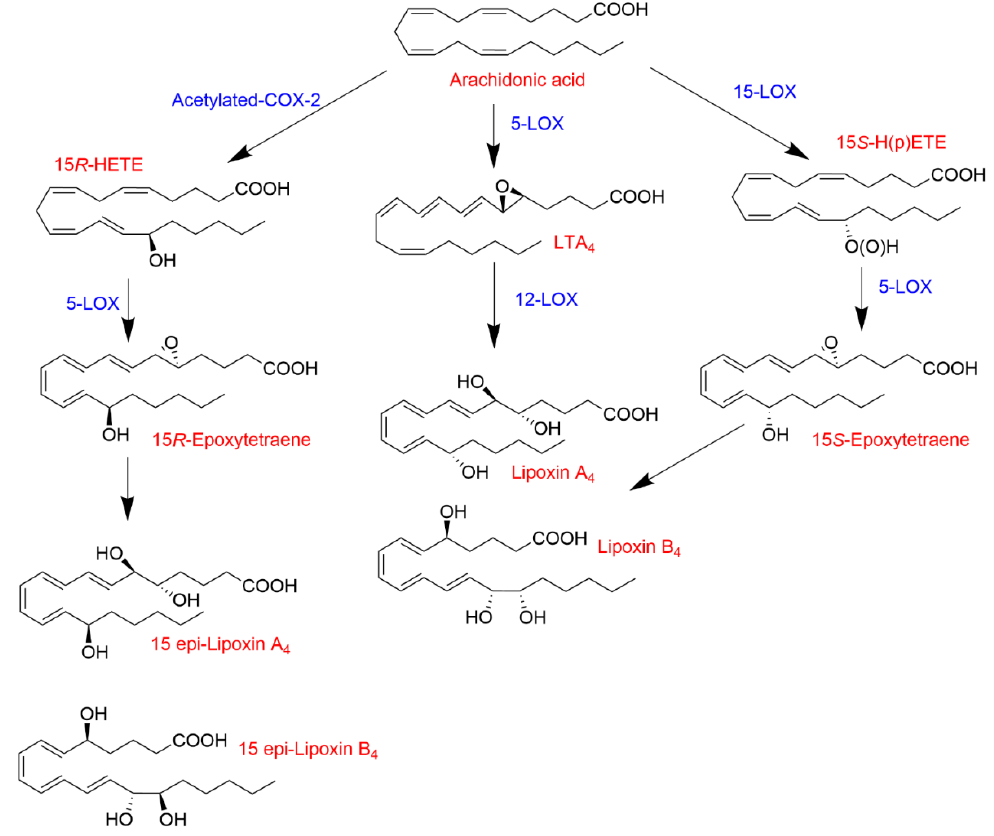
Figure 2. Biosynthesis of LXs and aspirin-triggered LXs.